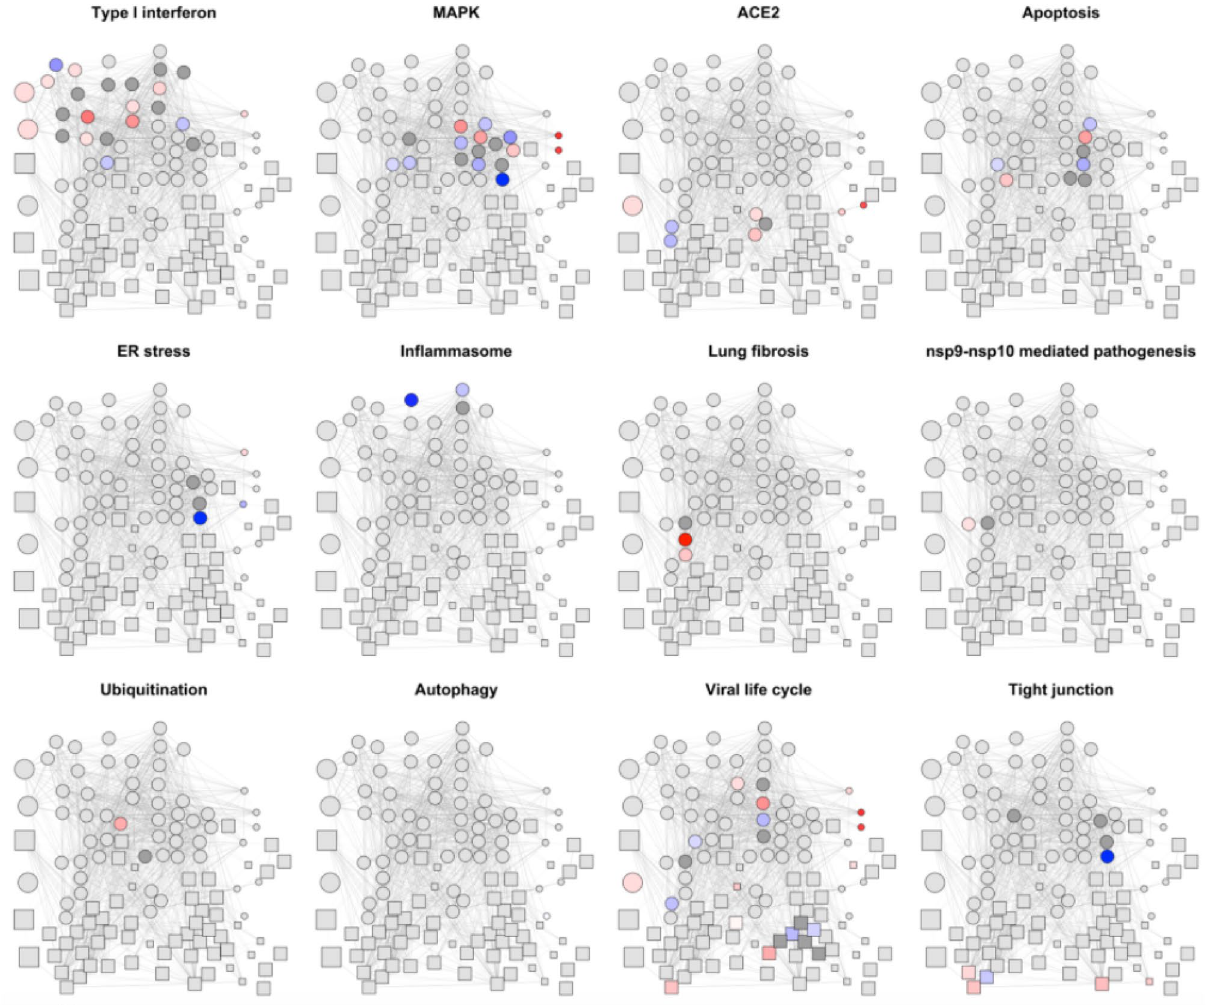
Figure 2. The same network as in Fig. 1 is shown here for each of the WikiPathways , the biological process “Viral life cycle” and the KEGG pathway tight junction 30 . The color code indicates the gene mean log2FC from genes upregulated in DS (red) to genes downregulated in DS (blue). When this information is not known the gene is in dark gray